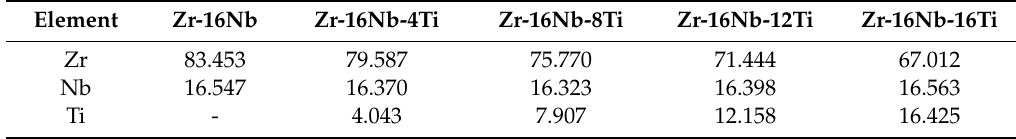
Table 1. Chemical compositions of the Zr-16Nb-xTi alloys determined by EDS (wt.%).